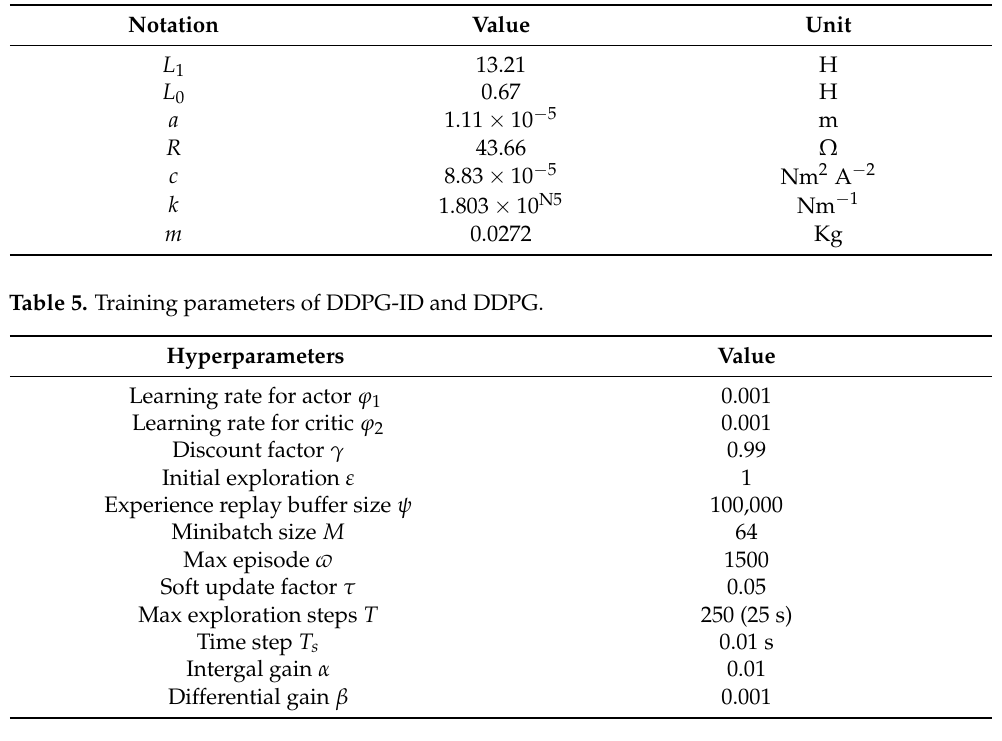
Figure 7. Observation result of ASMDO with d 1 . ( a ) Observing result based on the ASMDO. ( b ) Ob- serving error based on the ASMDO. Table 4. Parameters of the micropositioner model.